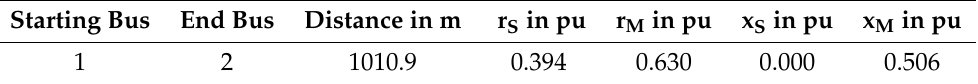
Table 3. Overview of used cable parameters.